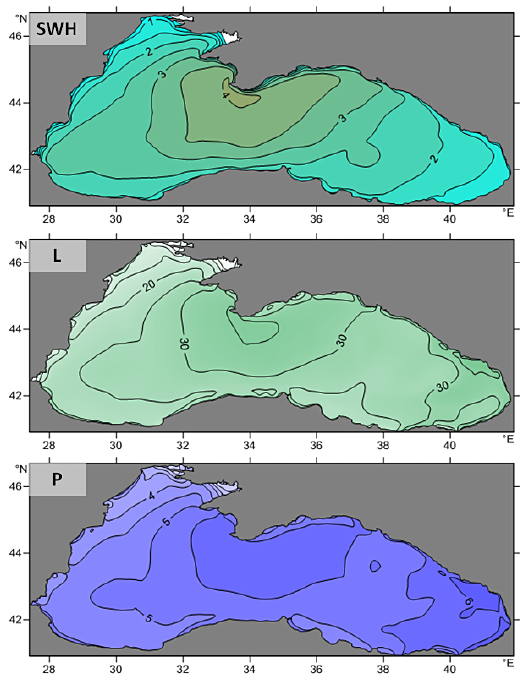
Figure 12. Maps of calculated significant wave height [m], wave length [m] and period [s] maxima in summer.